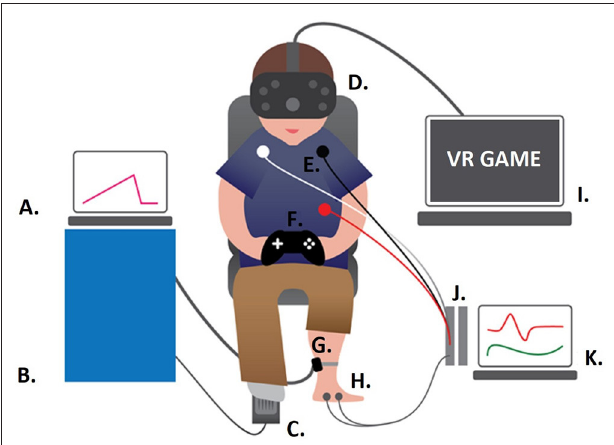
FIGURE 1 | Experimental Set-Up. (A) Laptop operating the thermal stimulator; (B) PATHWAY 30 x 30mm ATS thermal stimulator (Medoc, Ltd.); (C) foot switch; (D) htc Vive ; (E) ECG electrodes; (F) Xbox controller; (G) thermal stimulator attached to the non-dominant leg (calf); (H) EDA electrodes; (I) gaming computer streaming Subnautica to the head mounted display; (J) BIOPAC modules; (K) computer running AcqKnowledge to record the psychophysiological